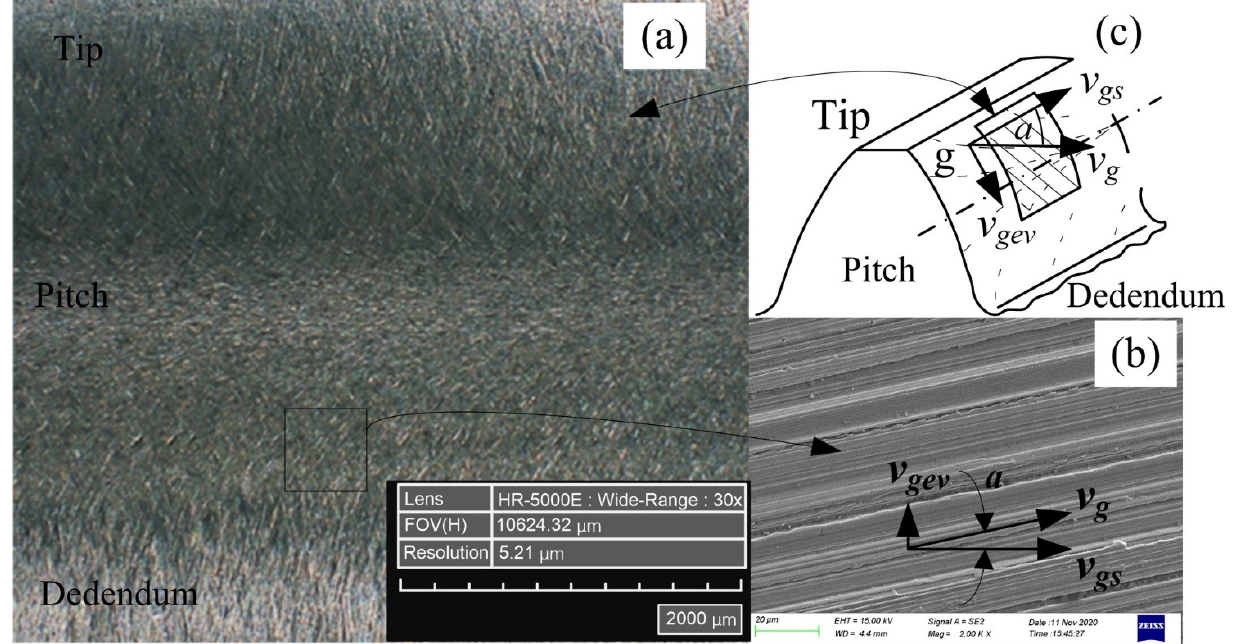
Figure 5. Modeling of sliding velocity of abrasive grains on tooth surface. ( a ) Honing texture of single tooth surface; ( b ) Honing speed decomposition; ( c ) Local enlarged view of ( a ).